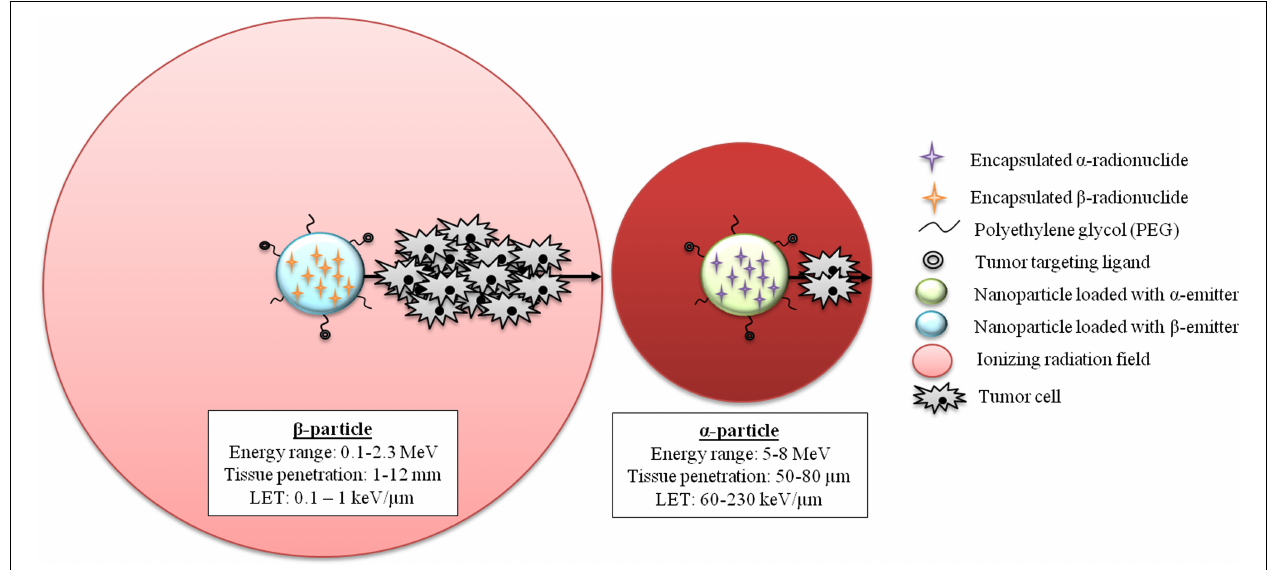
FIGURE 4 | Schematic depiction of nanoparticles loaded with beta- and